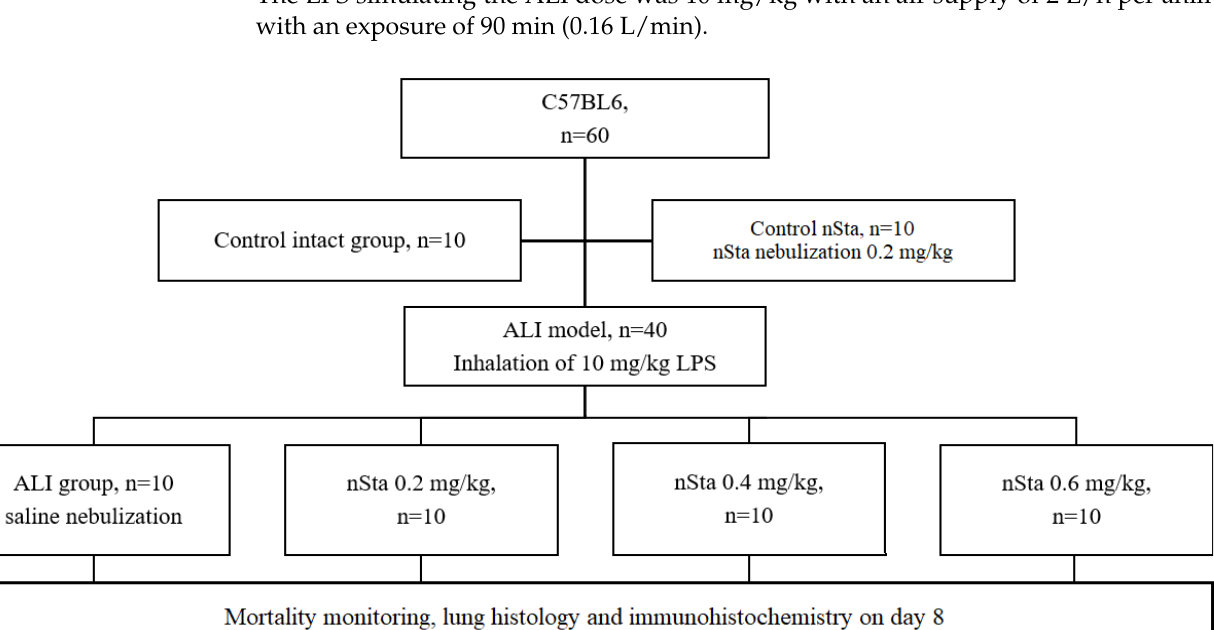
Figure 7. Flow chart of the second part of the study: evaluation of the effects of nSta on the mice ALI model.